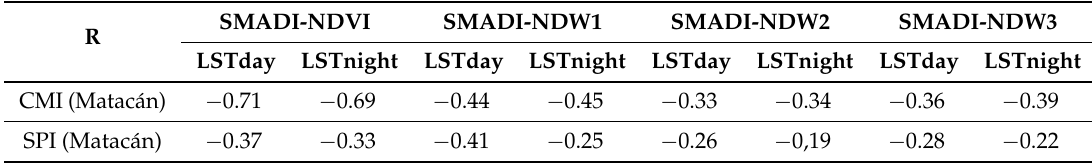
Table 3. Comparison (Pearson coefficient) between CMI and SMADI at the Matacán station. All the correlations have a p -value <